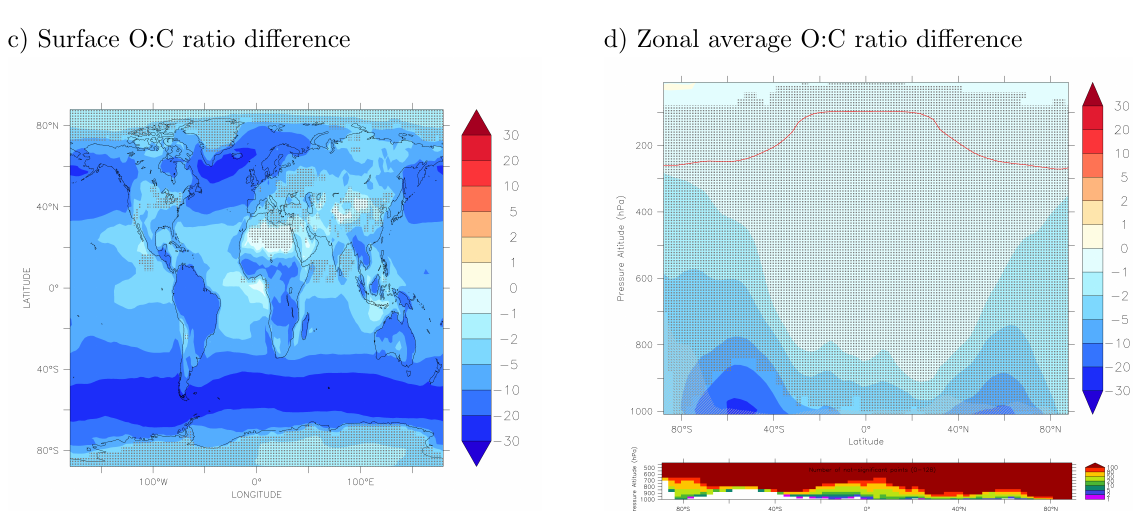
Fig. 3. Annual averages of the O:C ratio at the surface (panel a ) and in the zonal average (panel b ) for the Ageing-BG simulation. The dotted regions are those in which the difference to the constant O:C ratio of the reference simulations is of a low statistical significance. The grey shaded area represents the zonal average orography, indicating less data points in these regions. The lower panel in this graph determines the number of points with differences of low significance. The red line represents the mean tropopause level. The lower panels ( c, d ) of the figure show the relative differences (in %) for surface (c) and zonal average (d) between the Ageing-LO simulation and the Ageing-BG setup. Again the black dotted regions mark regions of low statistical significance for the differences between the two simulations, and the number of points of low significance is displayed in the lower